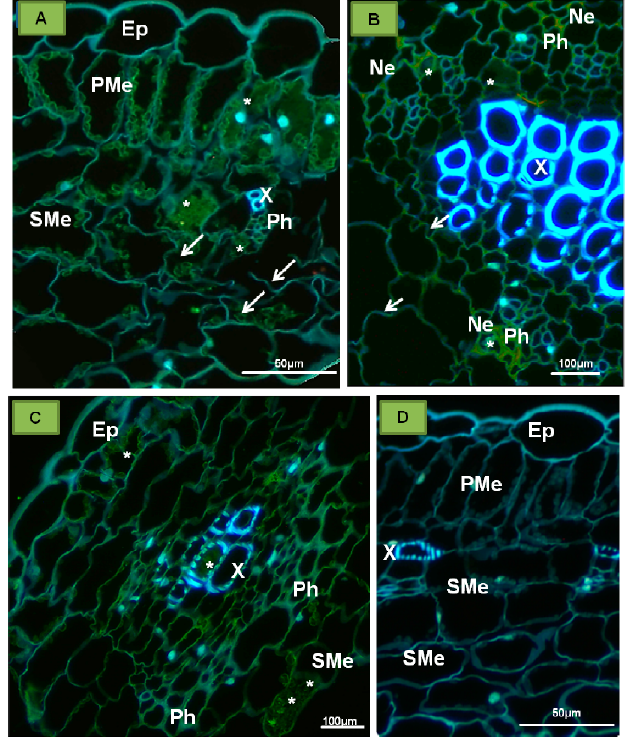
Figure 5. Immunofluorescent localization of coat protein in tobacco leaf of Samsun variety 15 days after inoculation with PDV. ( A ) The epitopes of coat protein (*) in phloem cells, palisade, and spongy mesophyll. Disintegration of spongy mesophyll cells observed (arrow); ( B ) The epitopes of coat protein (*) in necrotic phloem cells. Visible cell wall invagination of parenchyma cells (arrow); ( C ) The epitopes of coat protein (*) in the spongy mesophyll cell and tracheal element; ( D ) Fragments of leaf blades inoculated only with buffer after 15 days. No CP epitopes observed. Abbreviations: Ep—epidermis, PMe—palisade mesophyll, SMe—spongy mesophyll, X—tracheal element of xylem, Ph—phloem, Ne—necrosis. Kozieł et al. [32]